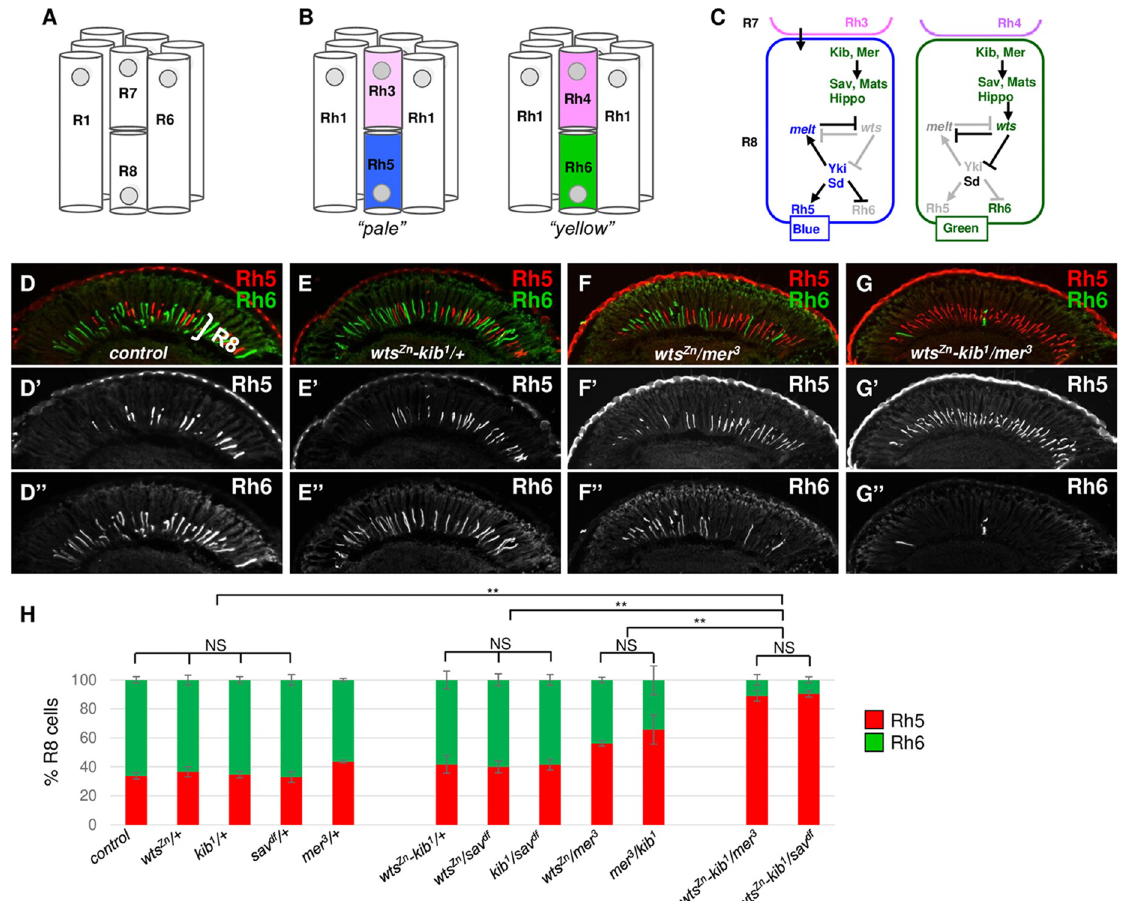
Fig 1. Tripe heterozygote-based phenotype enhancement assays for R8 subtypes. (A) Schematic of an adult ommatidium with six outer photoreceptors (PRs) (R1-R6) and two inner PRs (R7 and R8). (B) Two main, pale (p) and yellow (y), ommatidial subtypes and corresponding Rhodopsin (Rh) expression patterns. (C) The Hippo pathway and melt specify yR8 (Wts+, Rh6+) vs. pR8 (Melt+, Rh5+) fates. pR7s send instructive pR7-to-pR8 signals (arrow from pink pR7) to activate melt in yR8s, and Melt, together with Yki, represses wts expression. In yR8s, Hippo signaling suppresses Yki activity and represses melt expression. Genes or proteins that are inactive or not expressed are denoted by grey font, while those that are expressed and/or active are represented by blue, green or black font. (D-G) Adult eye cryosections stained for Rh5 (red) and Rh6 (green) from control (D), wts Zn and kib 1 heterozygous (E), wts Zn and mer 3 heterozygous (F), or wts Zn , kib 1 and mer 3 triple heterozygous (G) flies. (H) Quantification of Rh5- and Rh6-positive R8s in control flies as well as flies with Hippo pathway heterozygous, double heterozygous or triple heterozygous mutations. Graph presents proportion of R8s (y axis) that express Rh5 (red) or Rh6 (green). Two-tailed, unpaired t test. NS: not significant. �� P < 0.001. Error bars represent standard deviation. control: n = 8 retinas, n = 1986 R8s; wts Zn /+: n = 8 retinas, n = 2036 R8s; kib 1 /+ : n = 8 retinas, n = 1796 R8s; sav df /+ : n = 7 retinas, n = 1709 R8s; mer 3 /+ : n = 6 retinas, n = 1488 R8s; wts Zn - kib 1 /+: n = 8 retinas, n = 1867 R8s; wts Zn / sav df : n = 8 retinas, n = 2001 R8s; kib 1 / sav df : n = 8 retinas, n = 1681 R8s; wts Zn / mer 3 : n = 6 retinas, n = 1421 R8s; mer 3 / kib 1 : n = 6 retinas, n = 1349 R8s; wts Zn - kib 1 / mer 3 : n = 6 retinas, n = 1421 R8s; wts Zn - kib 1 / sav df : n = 6 retinas, n = 1356 R8s. Refer to Supporting Information S1 Text for detail genotypes. Also see S1